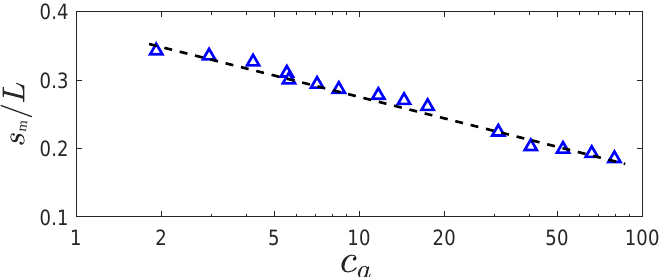
Figure 3. Relative location of the maximum deformation of the plates s m / L . Dashed line denotes a log trend ( x -coordinate in log